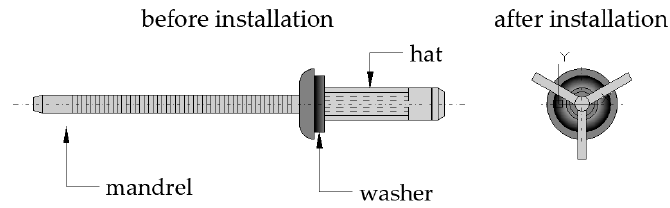
Figure 4. Scheme of a blind rivet before and after installation.